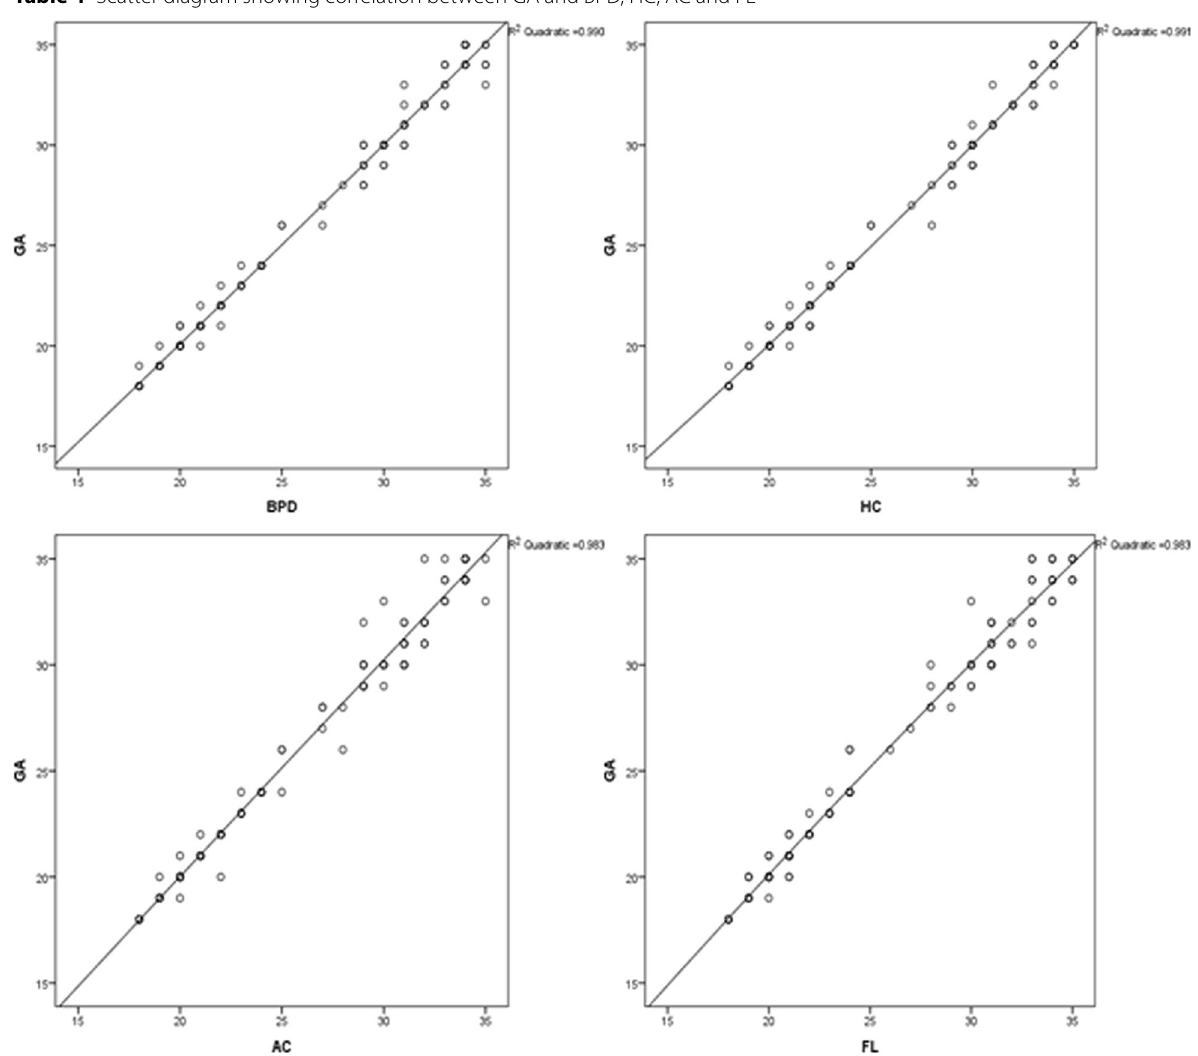
Table 4 Scatter diagram showing correlation between GA and BPD, HC, AC and